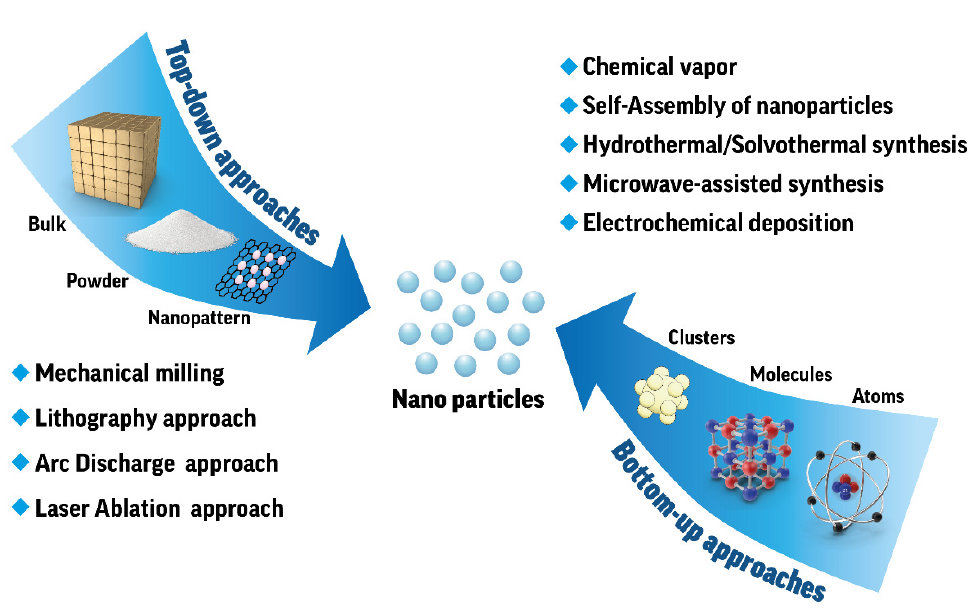
Figure 1. Approaches to nanoparticle preparation.